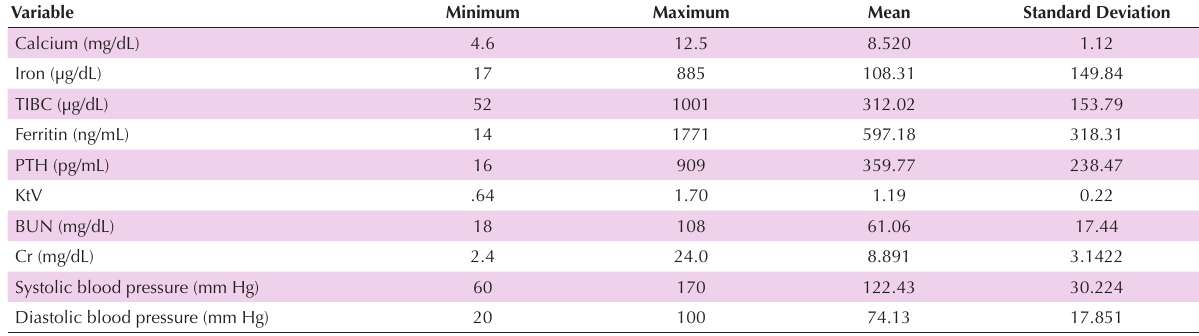
Table 2. Para-clinical characteristics of the patients undergoing hemodialysis Variable Minimum Maximum Mean Standard